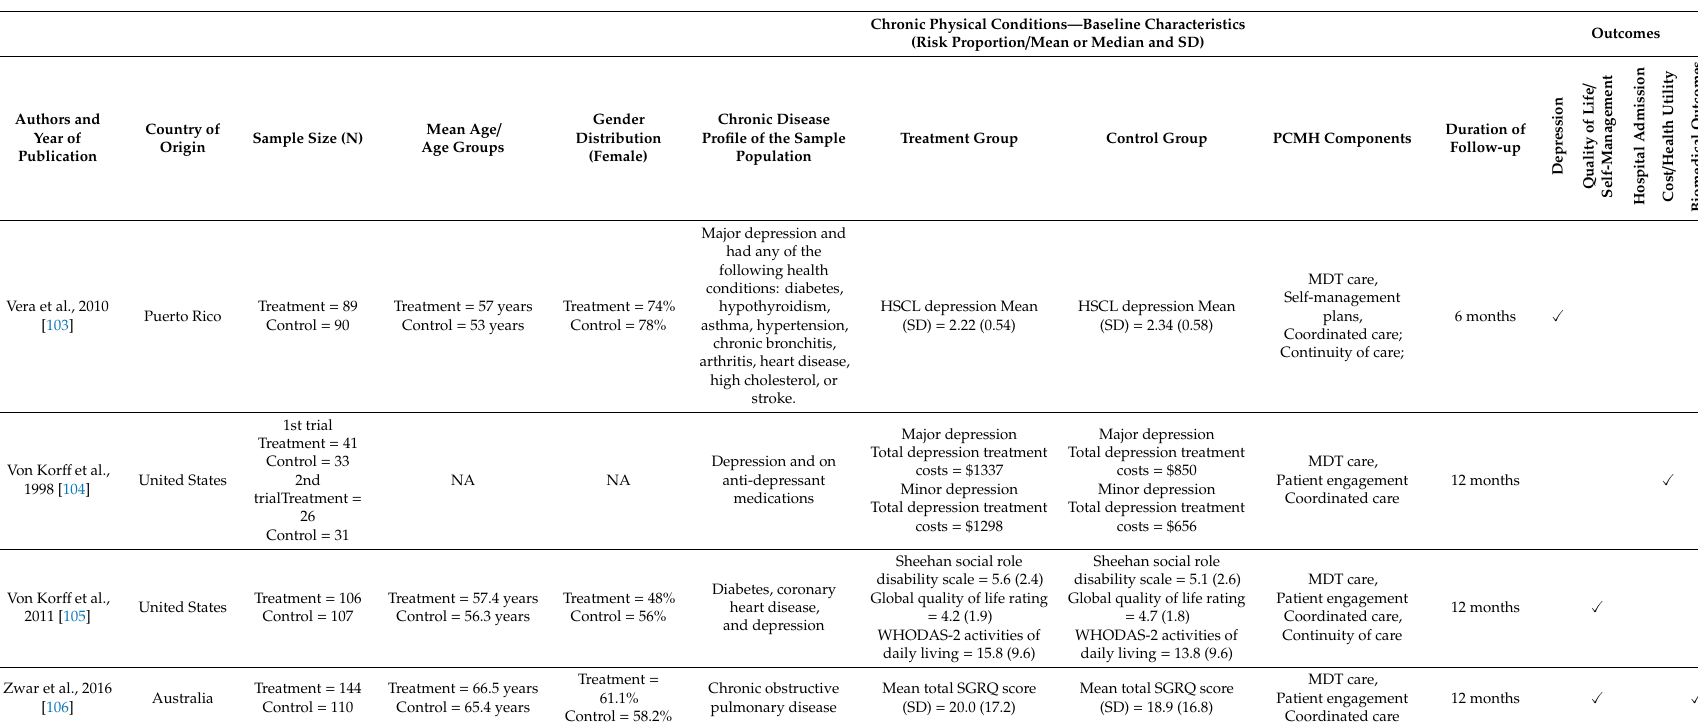
Chronic Physical Conditions—Baseline Characteristics (Risk Proportion / Mean or Median and